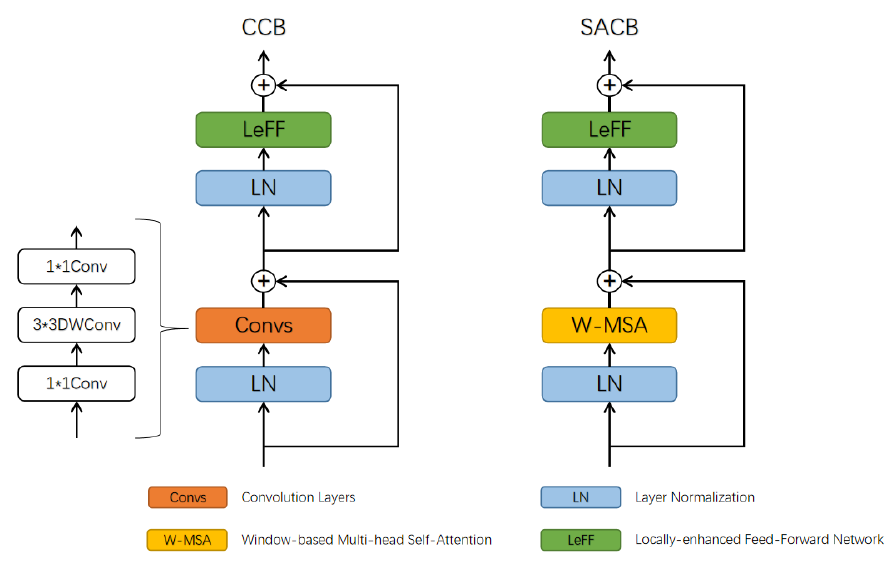
Figure 3. Structure of Convolution Cloudformer block (CCB) and Self-Attention Cloudformer block (SACB).